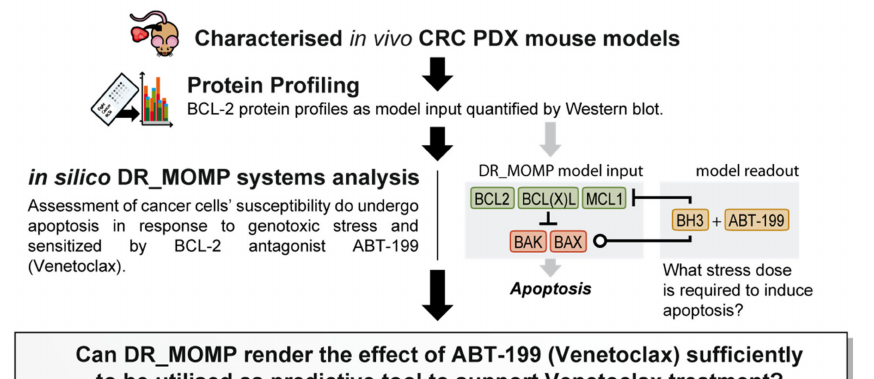
Figure 1. Schematic representation of the experimental workflow. The sensitivity of tumour cells to undergo apoptosis was calculated after quantitative protein profiling using the deterministic systems model DR_MOMP [7]. First, protein levels were calculated by quantitative Western blotting in proteins extracted from colorectal cancer (CRC) patient-derived xenograft (PDX) tumours, using cell lines as standards in which absolute BCL-2 protein levels were previously determined. Protein profiles then served as input into the deterministic systems model, DR_MOMP. The model calculates a ‘stress dose’ (pro-apoptotic ‘BH3 only protein dose’) required to induce mitochondrial outer membrane permeabilization (MOMP), the process leading to mitochondrial apoptosis. Kinetics of the BCL-2 antagonist ABT-199 were included in the DR_MOMP model [10] to determine sensitisation of the apoptosis signalling network by the BCL-2